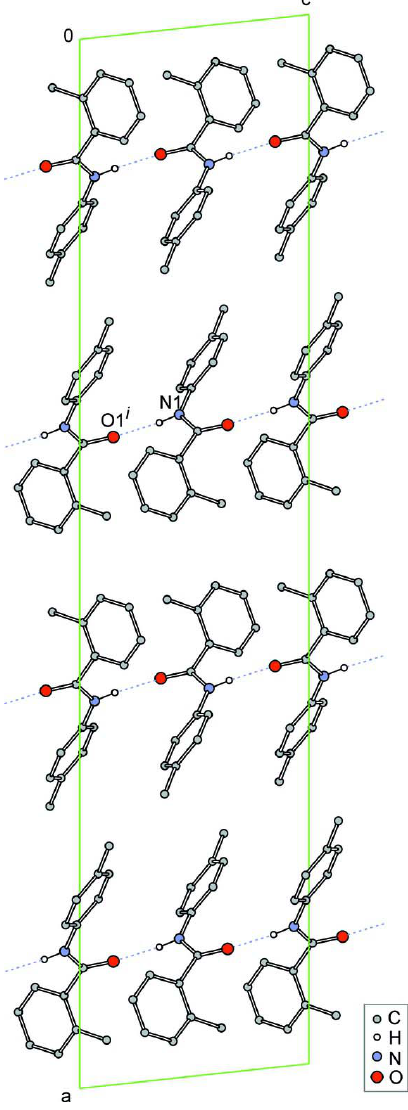
Figure 2 Part of crystal structure of (I) viewed down the b -axis. Hydrogen bonds N1–H1N···O1(i) give rise to infinite molecular chains running along the c axis. Symmetry code: (i) x ,- y + 1, z - 1/2. H atoms not involved in hydrogen bonding are omitted and hydrogen bonds are shown as dashed